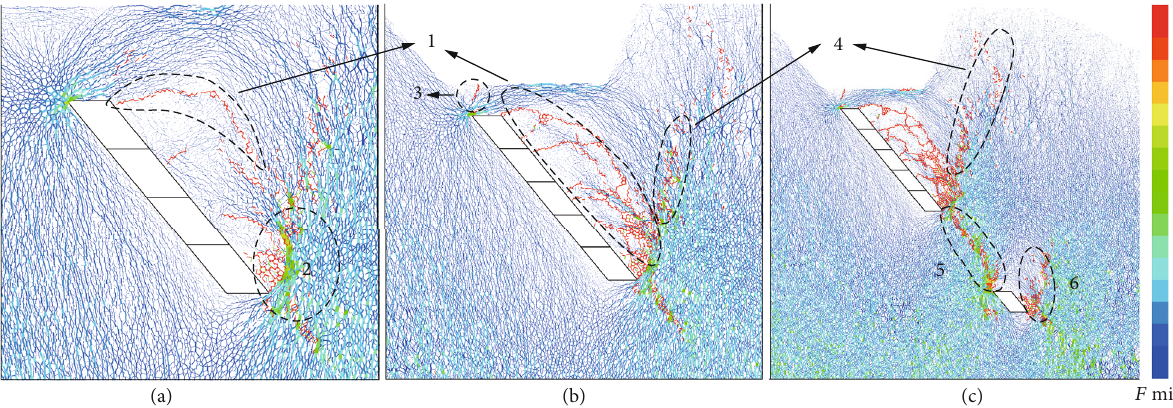
Figure 14: Mesoscale force fi eld distribution and crack propagation during the fourth, fi fth, and sixth excavation